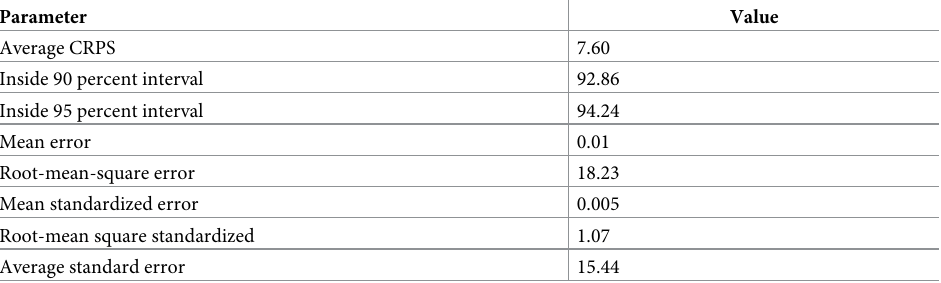
Table 2. Cross-validation results for model.